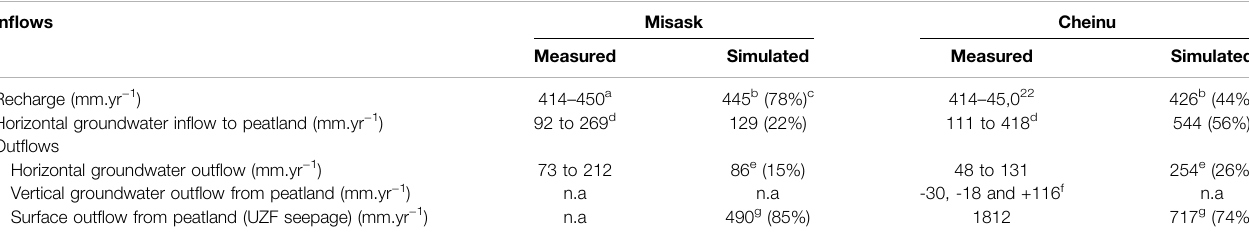
TABLE 2 | Measured and simulated in fl ows and out fl ows to and from the Misask and Cheinu peatlands. In fl